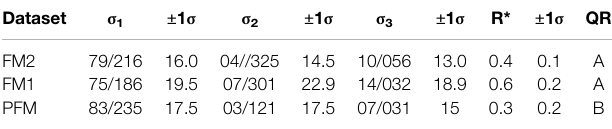
TABLE 2 | Seismological and Geological stress tensor parameters showed in Figure 10E for the Irpinia fault systems. σ 1 , σ 2 , σ 3 (cid:1) principal stress axes; Φ